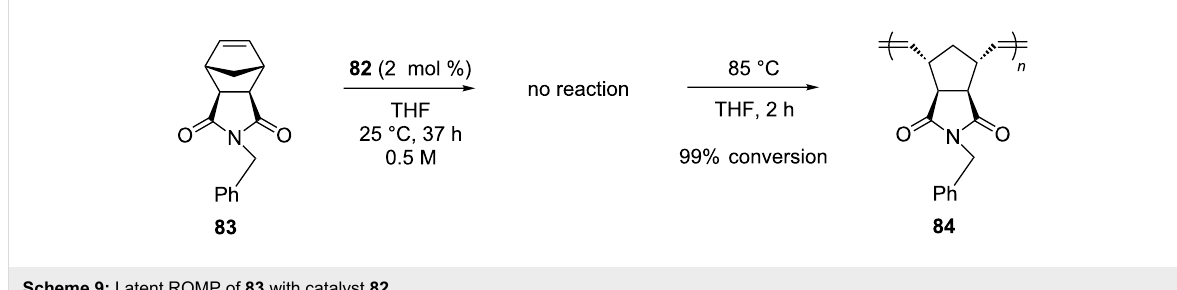
Scheme 9: Latent ROMP of 83 with catalyst 82 .